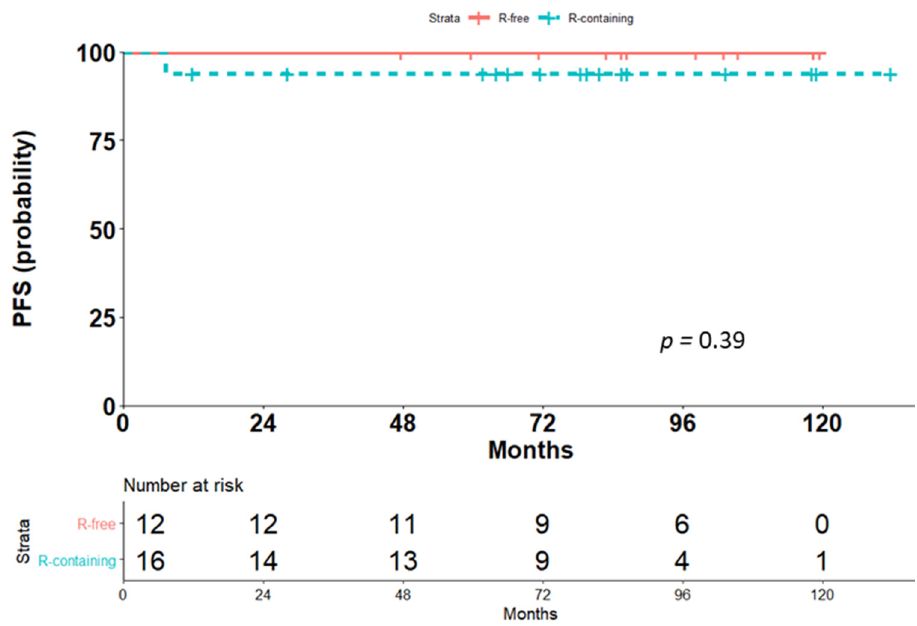
Figure 2. Comparison of overall survival (OS) for the two treatment groups, Rituximab-containing (R-containing) and Rituximab-free (R-free).